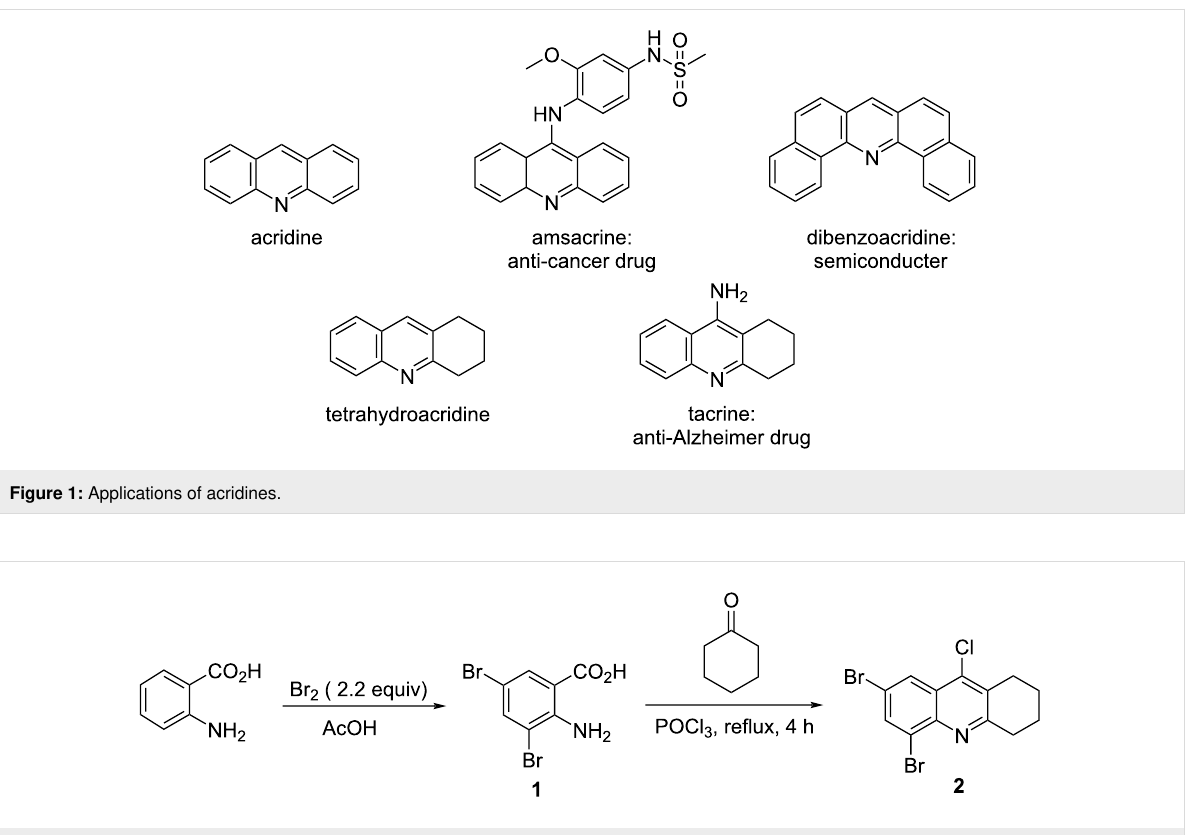
Scheme 1: Synthesis of 2,4-dibromo-9-chloro-5,6,7,8-tetrahydroacridine ( 2